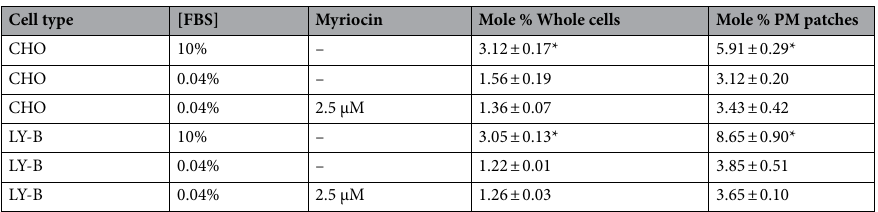
Table 1. Myriocin effect on cholesterol concentration in whole cell or plasma membrane lipid extracts from CHO or LY-B cells grown under limiting SL concentration. Results are given as mole percent of total lipids in sample. Average ± S.D. (n = 3). *Results taken from Monasterio et al . 13